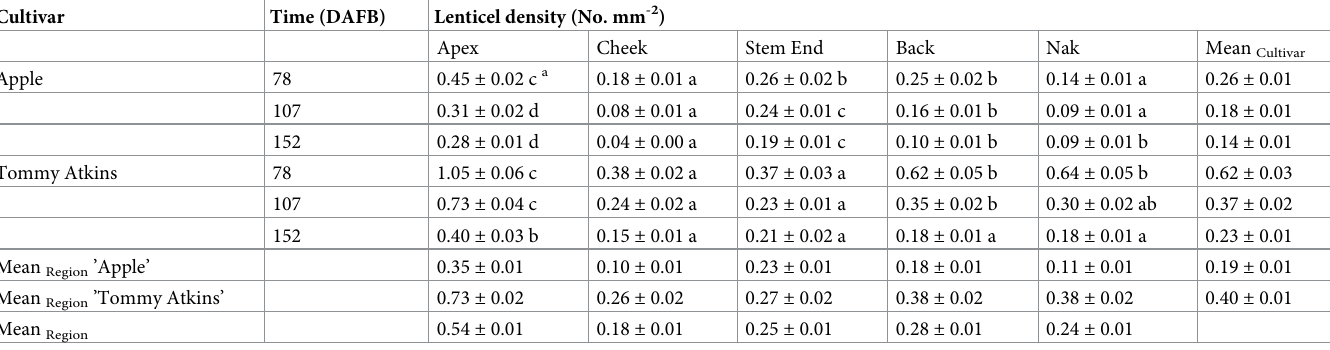
The ES were excised from the apex, cheek, stem end, back and nak regions of the same fruits at 78, 107 or 152 days after full bloom (DAFB). Data presented as means ± SE. The number of replicates was 30. a